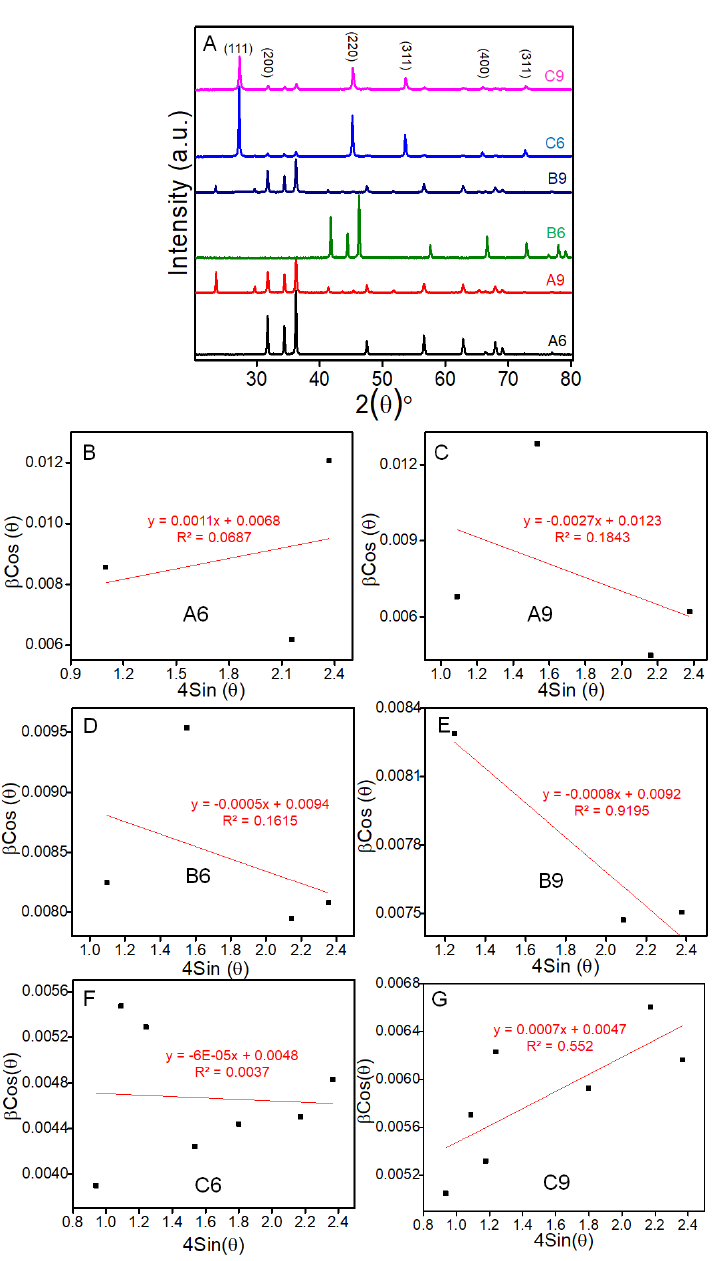
Figure 2. XRD Spectra representing formation of ZnSe nanostructures ( A ), and the crystallite size and strain of synthesized ZnSe calculated by using the W – H plot ( B – G ).